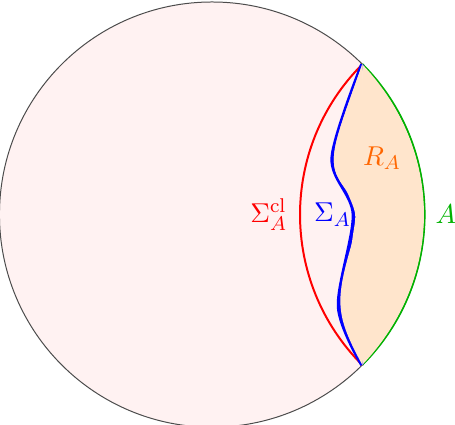
Figure 1 . A fixed time slice of an asymptotically AdS 3 spacetime with classical extremal surface Σ cl (red) given by the spacelike geodesic anchored on the boundary of the CFT interval A (green). The quantum extremal surface Σ (blue) is a spacelike curve that extremizes the generalized entropy A and the (quantum) homology surface R (orange) is the region bounded by Σ A